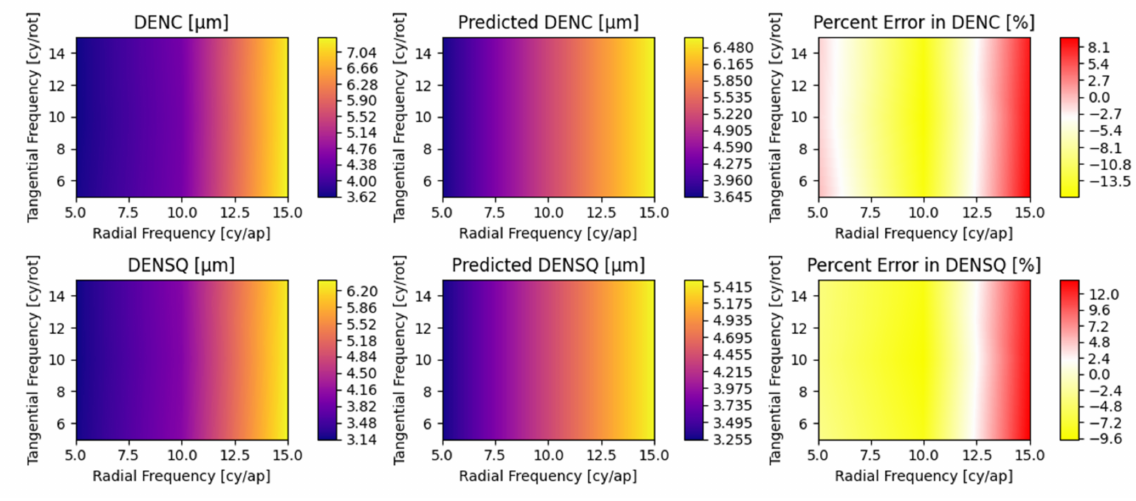
Figure A12. Radial Frequency versus tangential frequency. ( η = ζ = δ = 0, κ = 0.15, σ = 0.05, θ = 45 ◦ ).